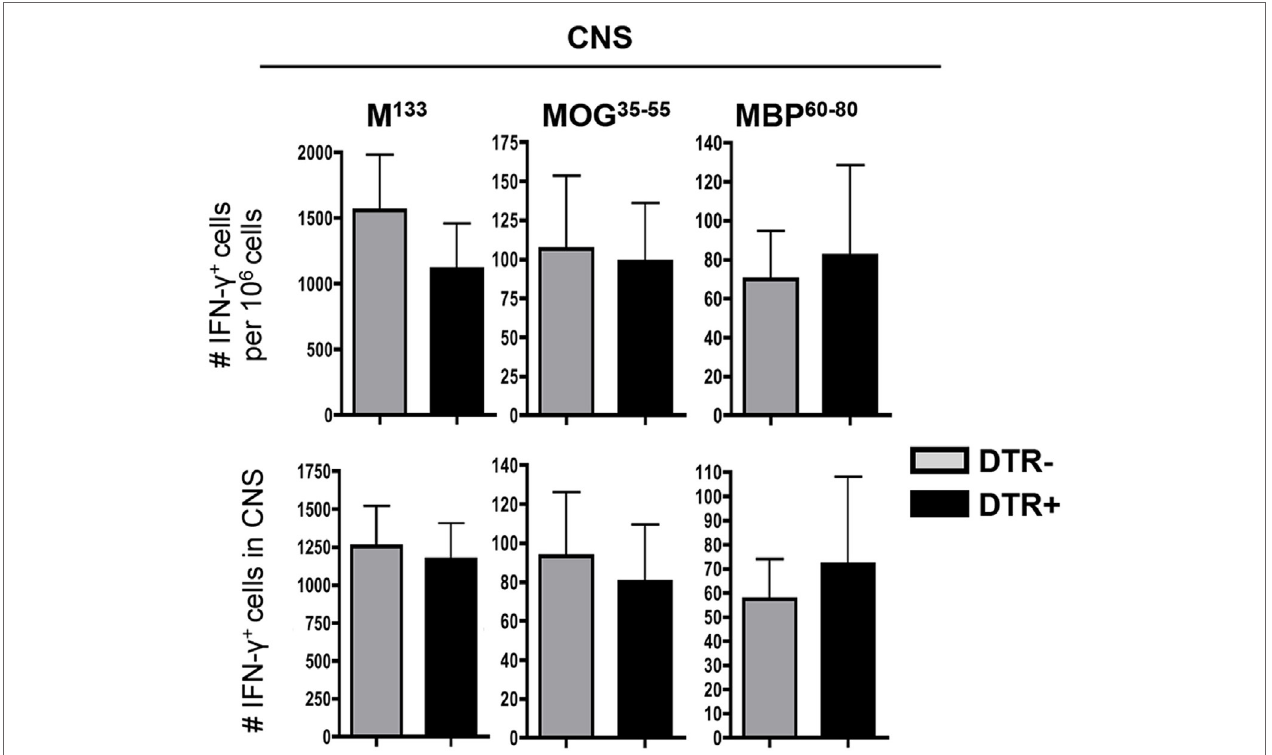
FigUre 5 | Foxp3 + Tregs do not affect cns sr T cells during chronic JhMV infection . Frequencies and absolute numbers of virus-specific M 133 , myelin- specific MOG 35 − 55 , and MBP 60 − 80 CD4 + T cells in CNS of JHMV-infected DTR − and DTR + mice treated with DT between d21 and d28 p.i. determined by ELISPOT. A number of spots detected in wells without stimulation were subtracted to exclude non-specific CD4 + T cells. Data represent the mean of two separate experiments with seven to eight pooled mice per group per